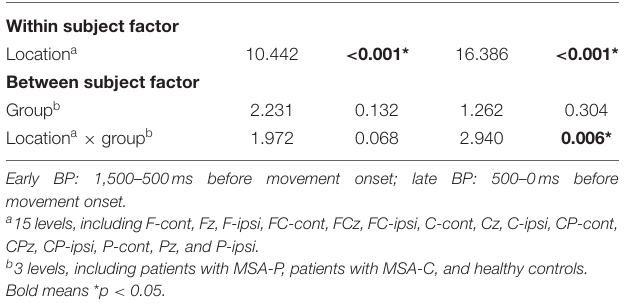
Early BP Late BP